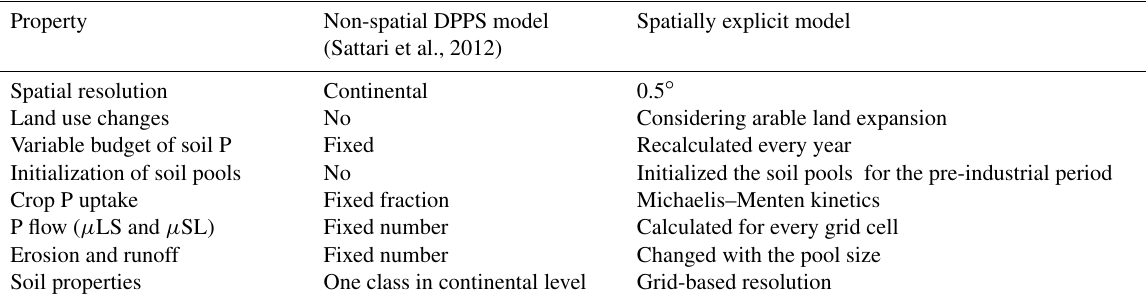
Table 1. Comparison between non-spatial DPPS (Sattari et al., 2012) and the spatially explicit DPPS model.